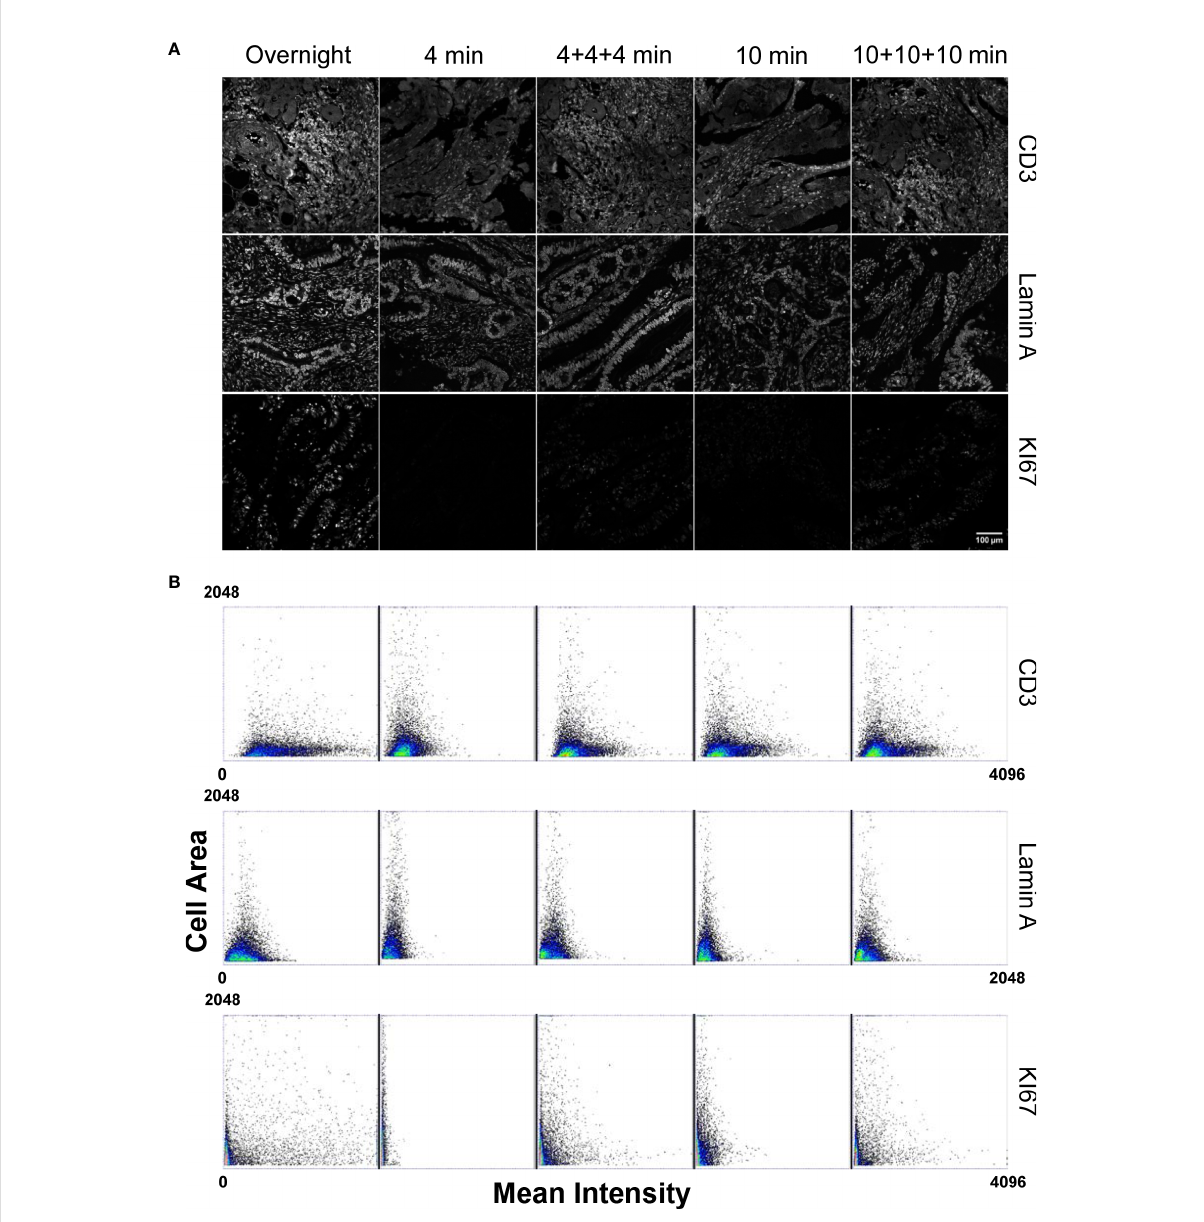
FIGURE 1 Comparison of the staining performances of a micro fl uidic based automated stainer at different incubation timing versus manual overnight procedure. (Panel A ) Staining conditions have been applied to: CD3 marker as representative of highly expressed and accessible antigens; Lamin A for nuclear, high expressed localization; KI67 directly conjugated antibody to test primary antibody staining ef fi ciency without ampli fi cation. Scale bar: 100 m m. (Panel B ) Dot Plots, obtained from single cell measurements (every spot in the graph represents a single cell), reporting the Mean Intensity of CD3, Lamin A and KI67 in relation to the single cell dimension (Cell Area) for different incubation times. Mean Intensity was calculated as the mean value of the pixels contained in the segmented cell mask. Cell area corresponds to the number of pixels contained in the segmented cell